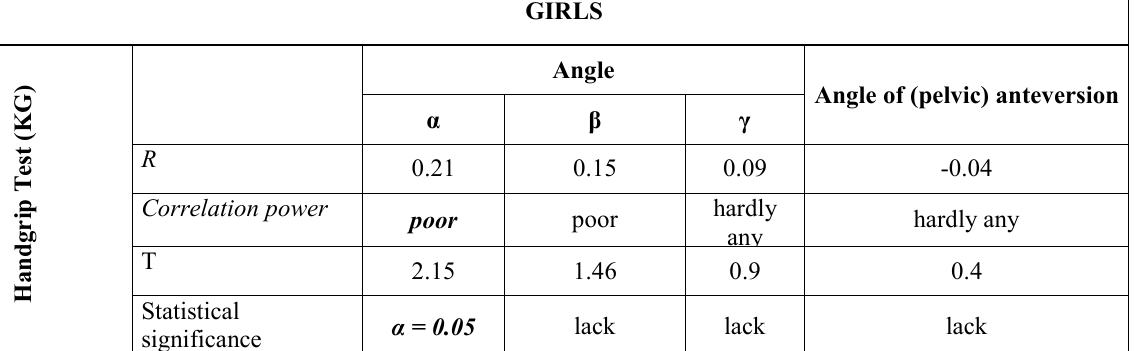
Correlations occurring between the angles characteristic of anterior-posterior pelvic tilts (upper thoracic - α, thoracic- lumbar - β, sacral-lumbar γ) and the angle of pelvic anteversion in the sagittal plane and the number of points scored in